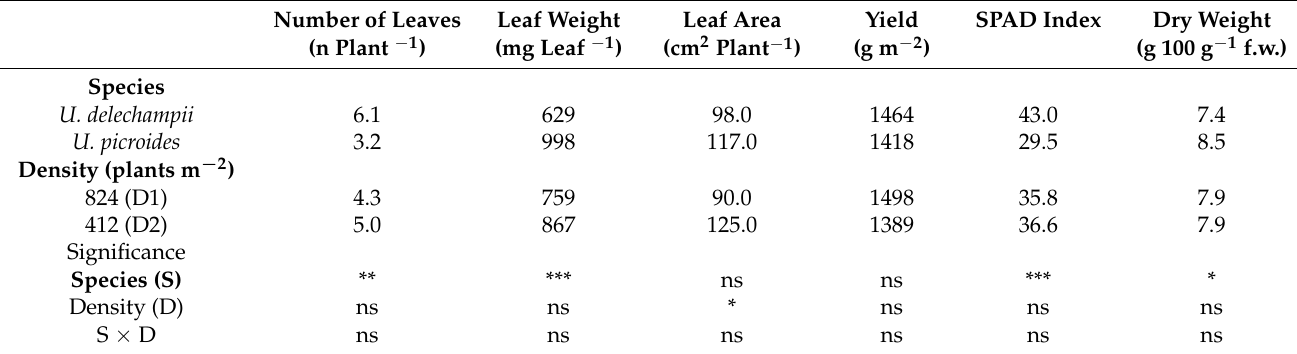
Table 2. Yield and physical traits of smooth golden fleece ( U. delechampii ) and prickly golden fleece ( U. picroides ) grown in a floating system at two sowing densities (second